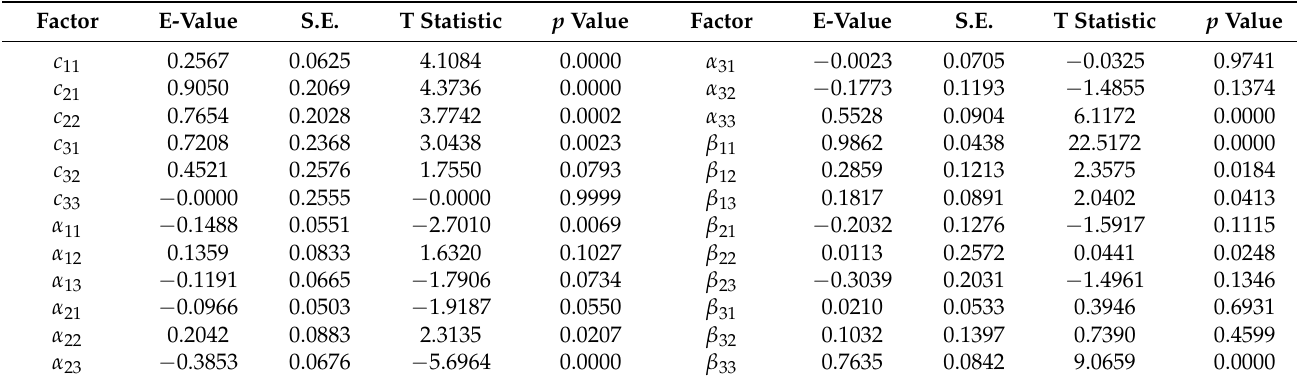
Table 13. BEKK variance equation estimation results in the third stage.